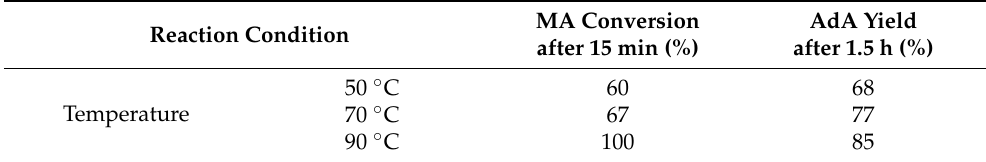
Table 3. Summary of the catalytic results at different temperatures. Reaction conditions: MA